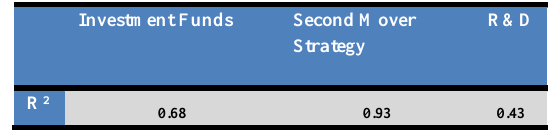
Table 3: R²- The Value of the Correlation between the Endogenous LVs